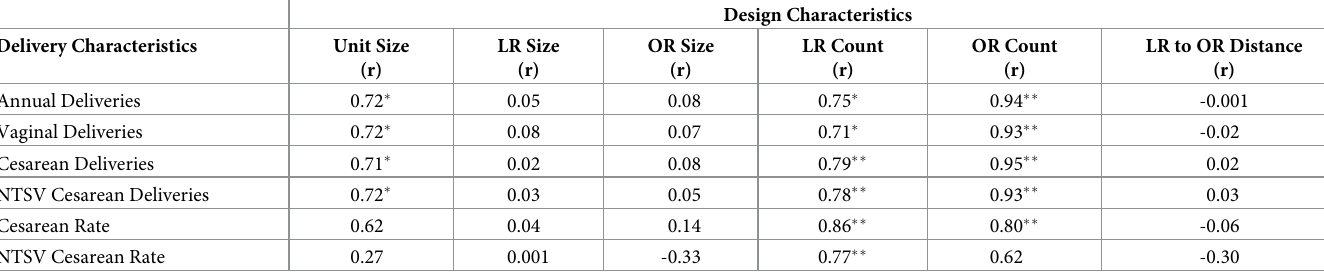
Table 3. Summary of correlation coefficients (r) between design characteristics and delivery